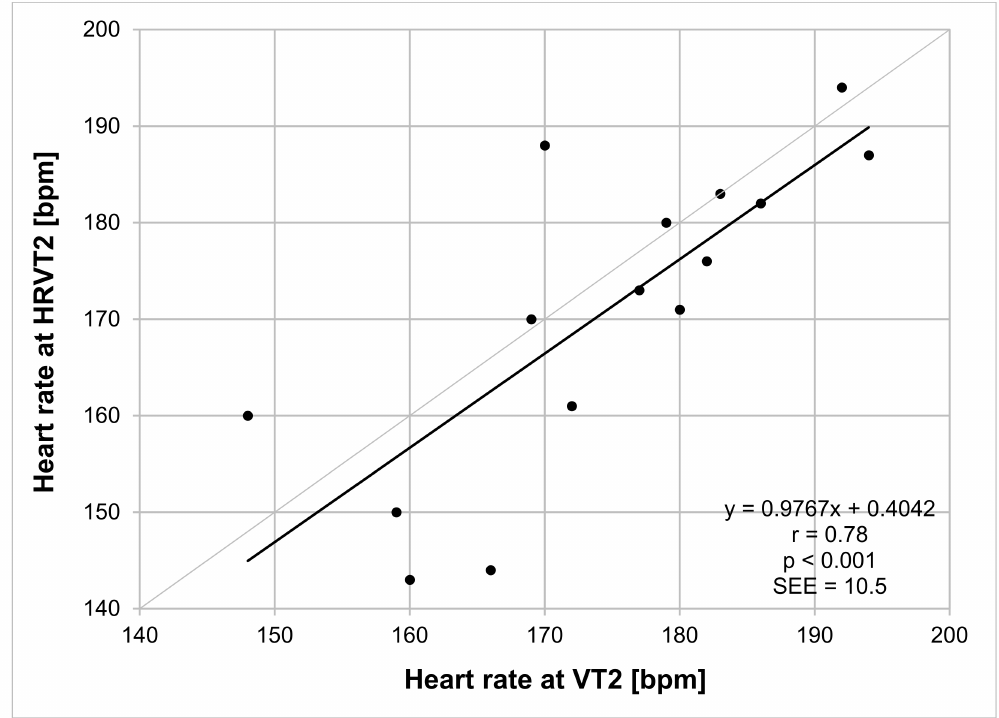
Figure 2. Regression plot analysis VT2 HR vs. HRVT2 HR for all participants. Bisection line in light gray. SEE: standard error of estimate; r: Pearson’s correlation